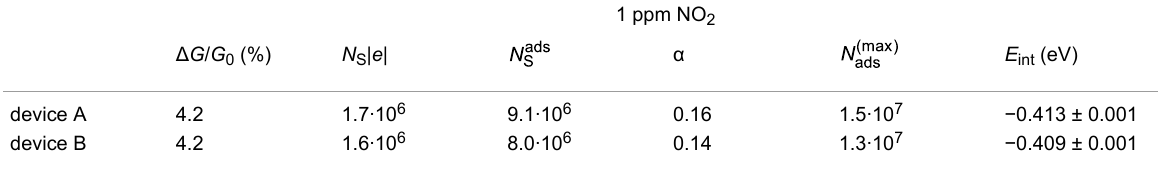
Table 1: Summary of the relevant quantities descending from the interaction between graphene (devices A and B) and 1 ppm of NO 2 during 10 min of exposure, calculated based on the responses reported in Figure 3. 1 ppm NO 2 Δ G / G 0